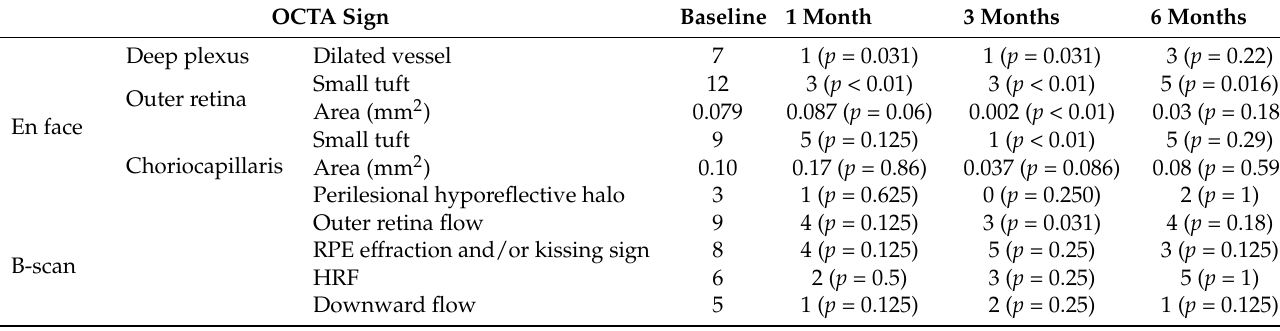
Table 1. Signs on optical coherence tomography angiography (OCTA) at baseline, at one month, three months, and six months after Brolucizumab